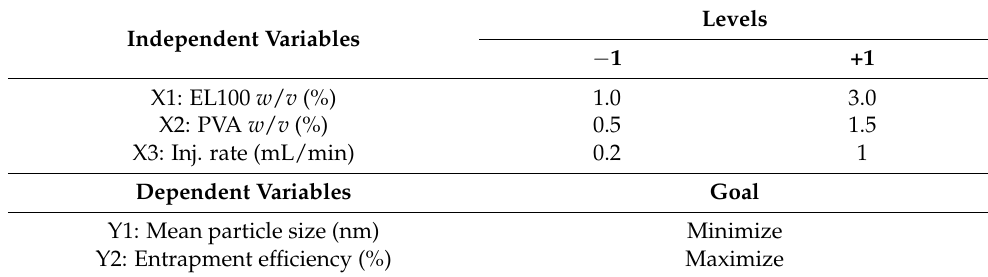
Table 1. Variables in CCD for bergenin nanoparticles and